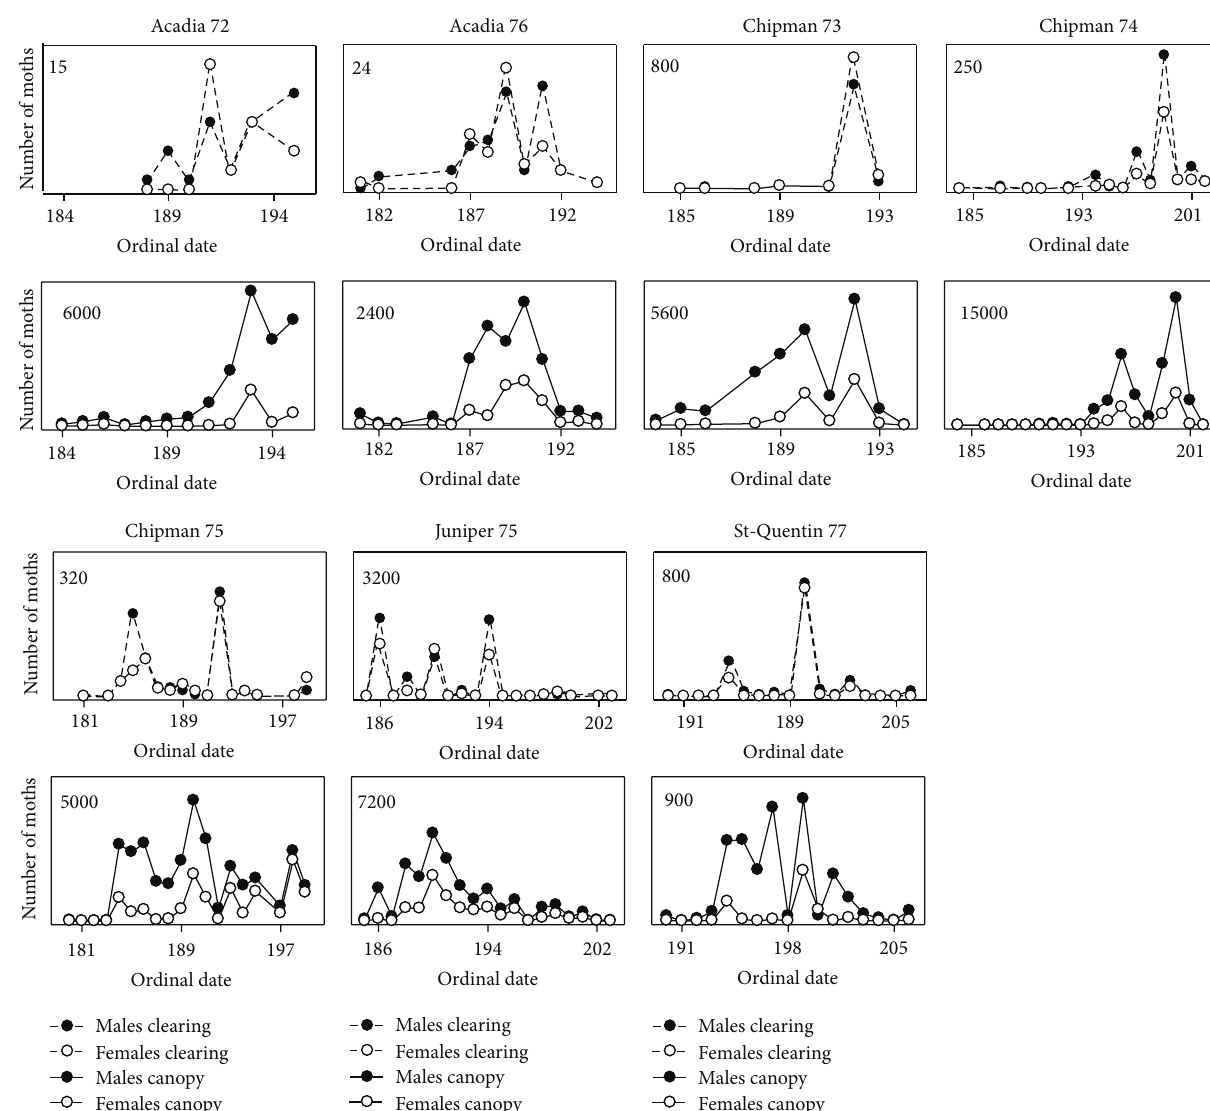
Figure 1: Daily abundance of adult spruce budworms captured at light traps deployed in tree canopies and forest clearings at different sites in New Brunswick, Canada. The numerical values within individual graphs represent the scale of the 𝑦 -axis for different locations and trap position.